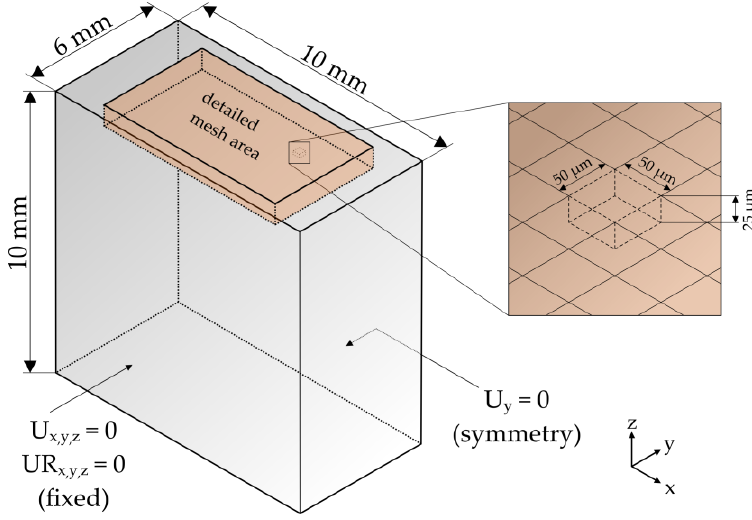
Figure 8. Geometry model and mesh resolution of the deep rolled workpiece area.